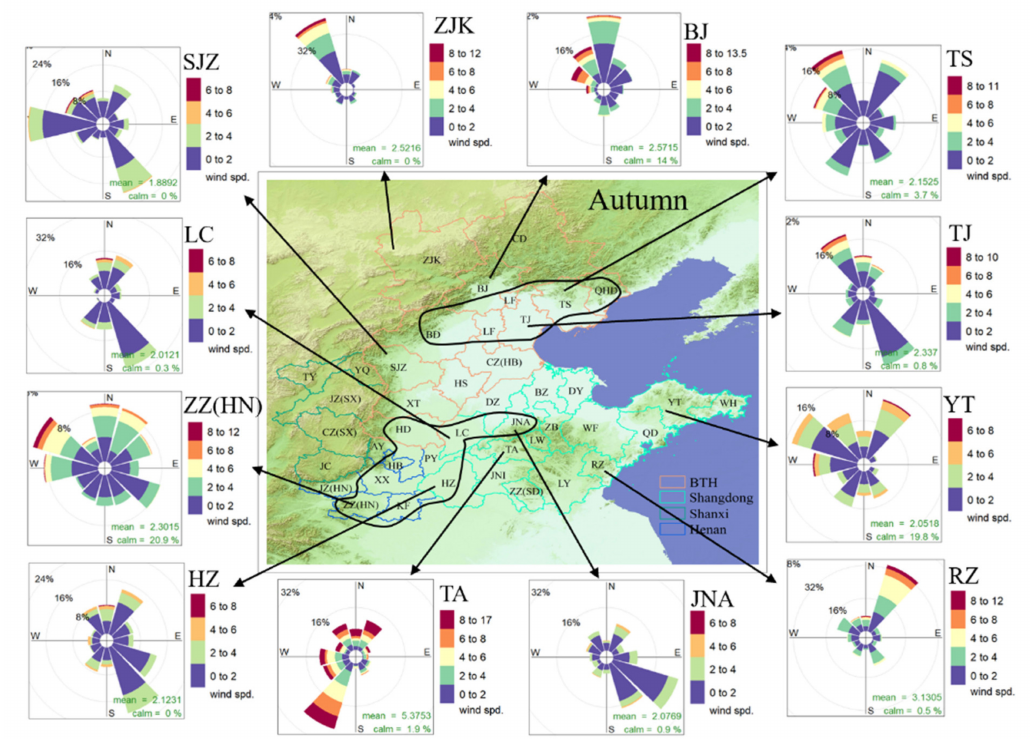
Figure 10. Topographic map and winds rose diagrams of some cities for the autumn of 2018 in the NNCP